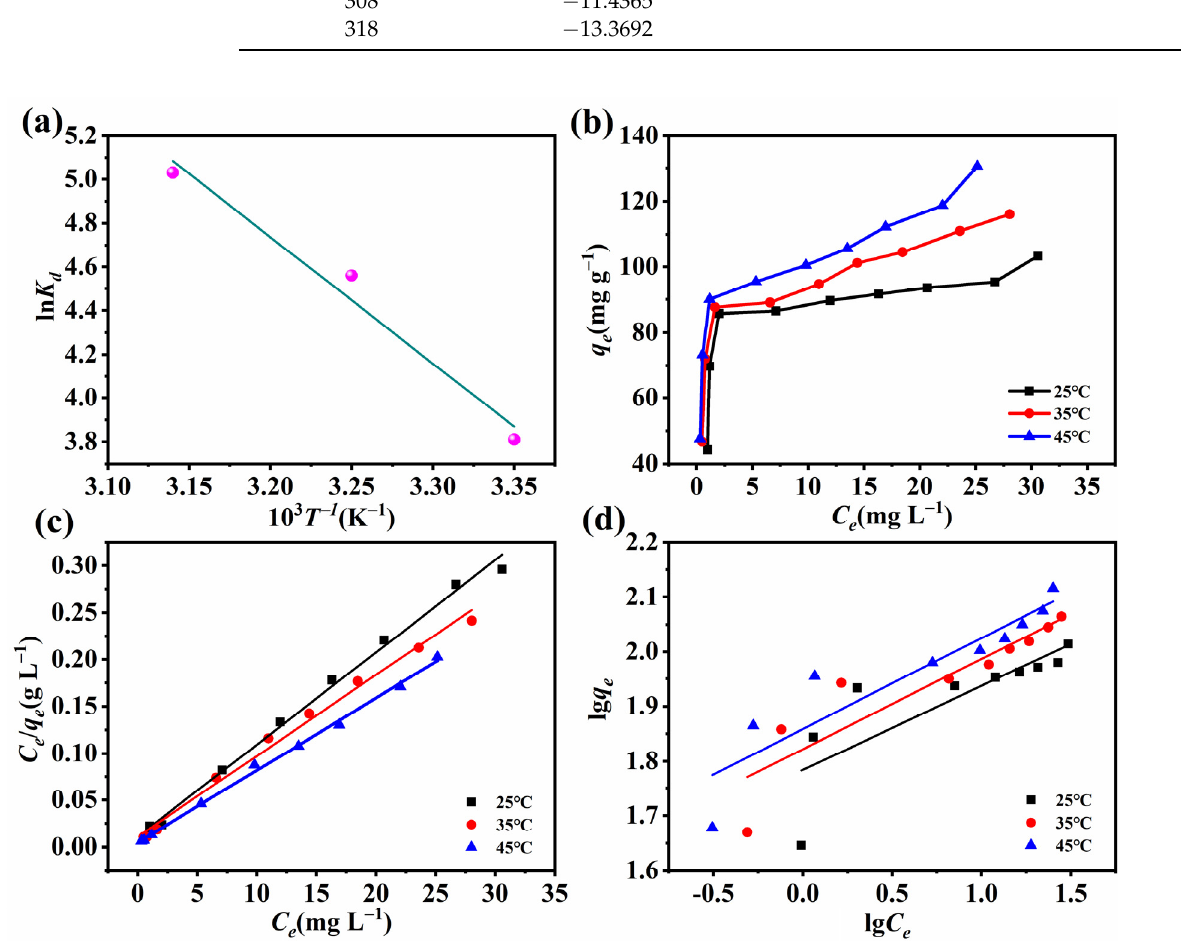
Figure 7. ( a ) Plotted ln K d against 10 3 T − 1 , ( b ) adsorption thermodynamics, ( c ) Langmuir model, and ( d ) Freundlich model. Table 3. Thermodynamic parameters of adsorption for fl uoride removal.